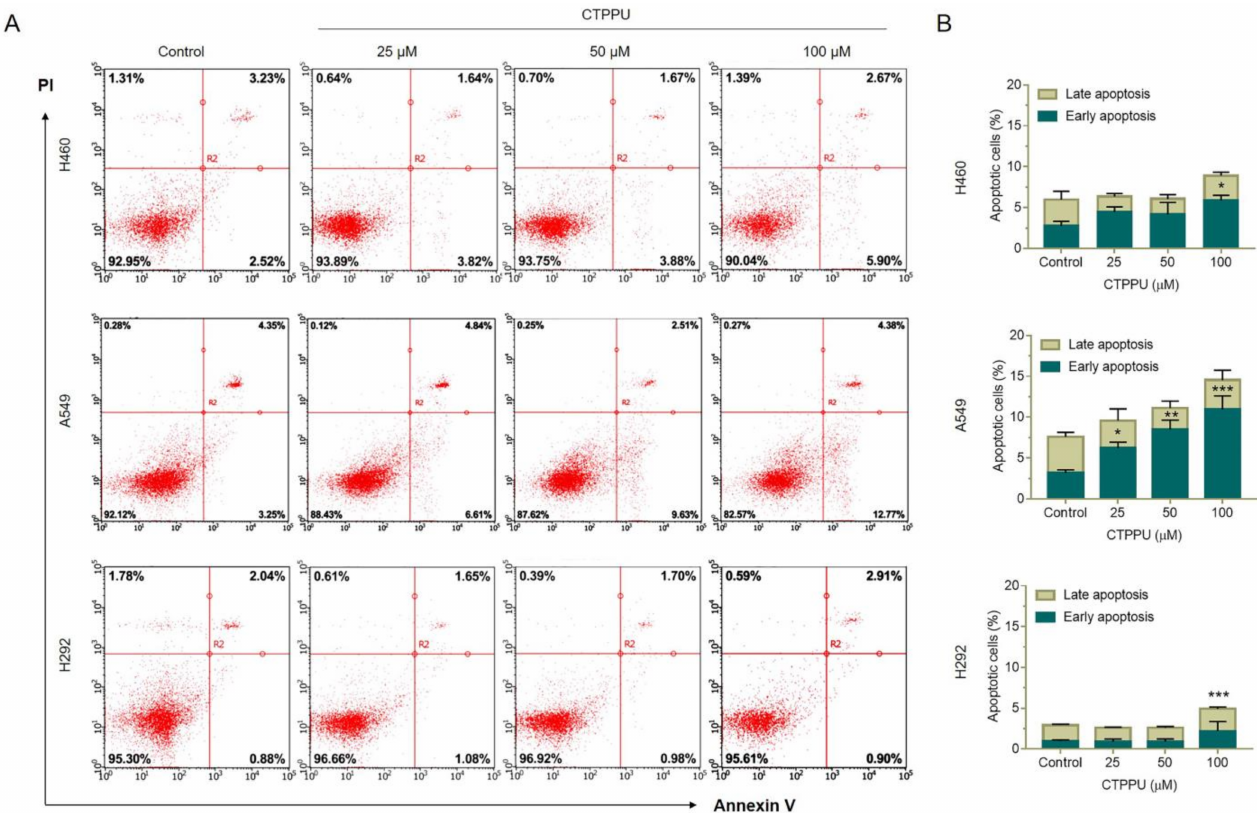
Figure 4. Effect of CTPPU treatment on cell apoptosis in NSCLC cells. ( A ) Apoptotic cells were evaluated using Annexin V FITC/PI double staining and analysis using flow cytometry. Represen- tative dot plots demonstrated the percentage of early apoptotic cells in the lower right quadrant (Annexin+/PI–) and late apoptotic cells in the upper right quadrant (Annexin+/PI+) at various con- centrations of CTPPU. ( B ) Bar graphs showed the quantitative results of A. The results are presented as mean ± SD, and all samples were measured independently in triplicate. Error bars are standard deviations. Significant differences are indicated as * p < 0.05, ** p < 0.01, and *** p < 0.001 compared with the